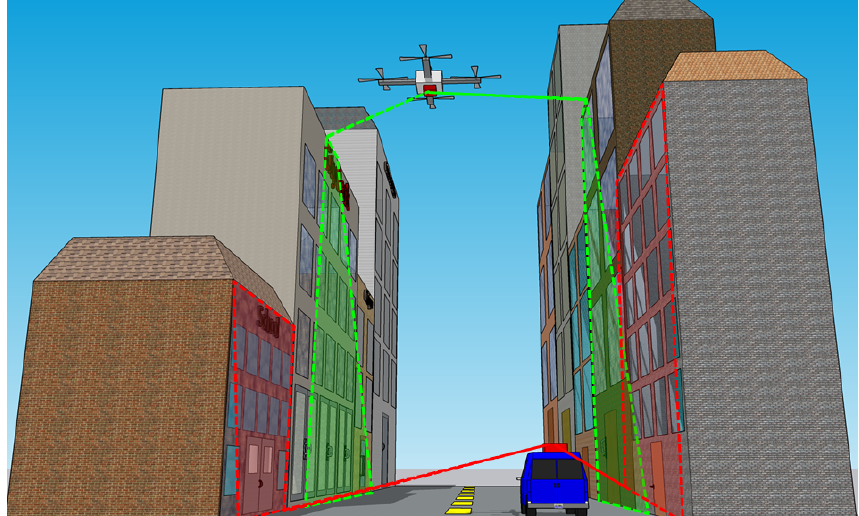
Figure 1. Scheme of different Multi-Sensor-Systems (MSS) capturing an environment. The green and red planes on the buildings are indicators for the scanner